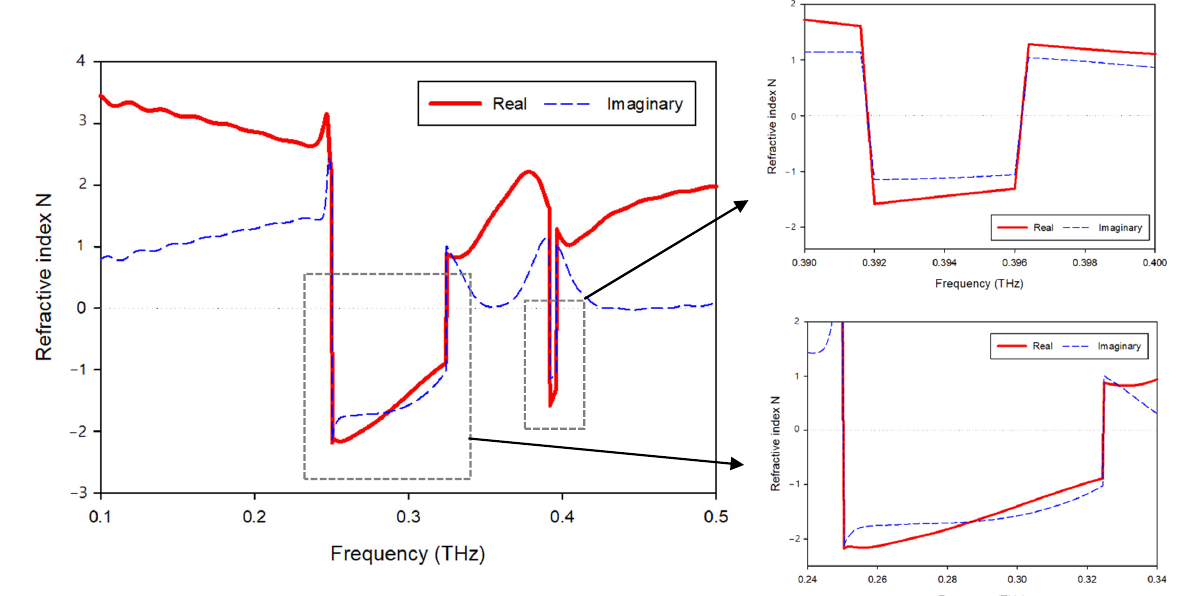
Figure 12. Refractive index of the proposed MMT.